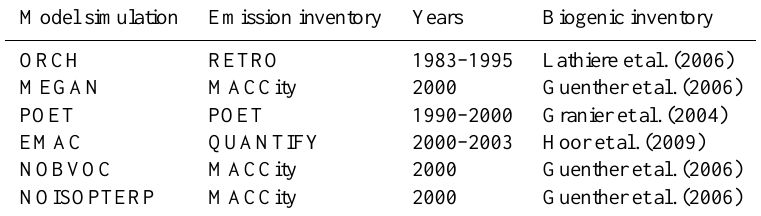
Table 1. An overview of the biogenic inventories used in the different CTM simulations for investigating the effects of